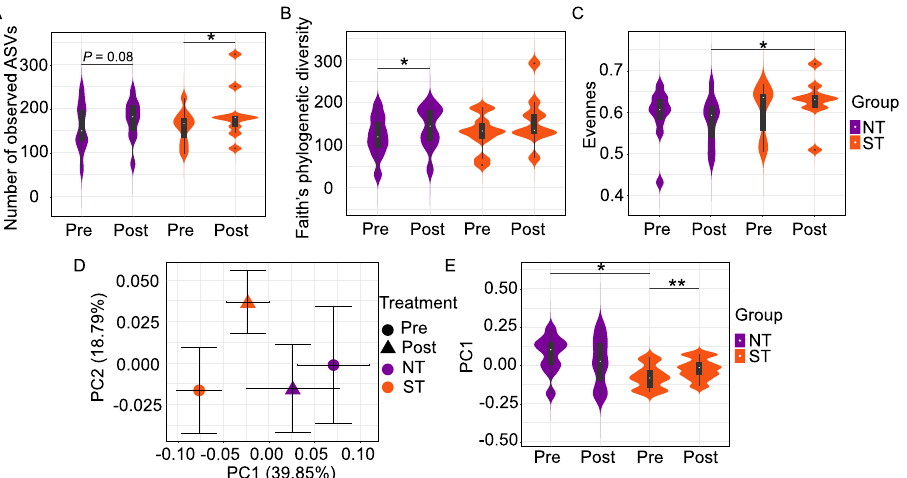
Figure 2. Oral Microbiome differences between PROP taster groups in response to the CPE rinse. Number of observed ASVs ( A ), Faith’s phylogenetic diversity ( B ), and Evenness ( C ) are alpha diversity metrics while beta diversity is based on Weighted UniFrac distance matrices shown in ( D ) as a 2D Principal Coordinate analysis (PCoA) plot and in ( E ) as violin plots. Each point in the PCoA plot represents the mean ( ± SEM) principal coordinate (PC) score of all individual subjects pre- and post-intervention. In the violin plots, rectangles show the medians and the interquartile ranges (IQRs), the whiskers denote the lowest and highest values that were within 1.5 times the IQR from the first and third quartiles. In NT/ST subjects, Wilcoxon matched-pairs signed-ranks test (two-tailed) was performed to compare pre- and post- intervention samples. Before/After CPE oral rinse, Mann-Whitney test (two-tailed) was performed to compare NT and ST subjects. * p < 0.05 and ** p < 0.01. Pre-intervention: NT n = 10, ST n = 10; Post-intervention: NT n = 10, ST n =